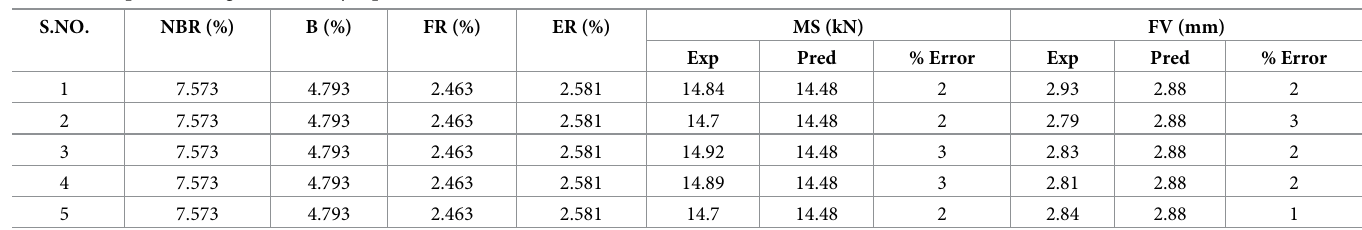
Table 11. Response during confirmatory experiments.